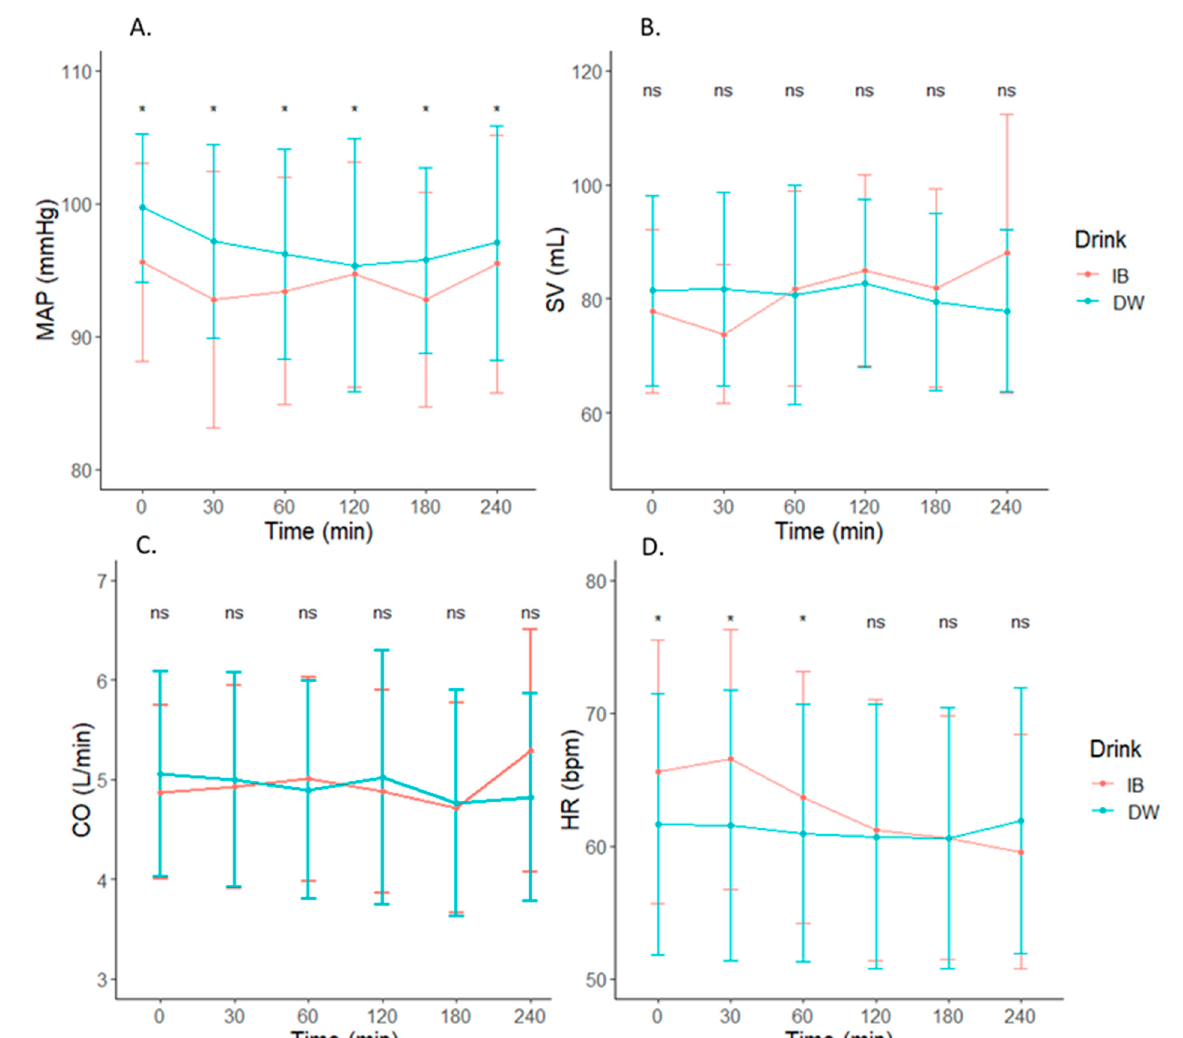
Figure 4. Changes in ( A ) mean arterial pressure (MAP), ( B ) stroke volume (SV), ( C ) cardiac output (CO), and ( D ) heart rate (HR) following consumption of isotonic beverage (IB) or distilled water (DW). * in ( A ) denotes a significant main effect of Drink ( p < 0.05). * in ( D ) denotes a significant Drink x Time interaction, p < 0.05. Non-significant interactions are denoted by ns in all figures. There was no Drink x Time interaction for lnRMSSD or lnLF ( p > 0.05, Figure 5A–D). lnHF was significantly greater 30-min post water ingestion compared to IB. There was no significant Drink ( p = 0.880), Time ( p = 0.465), or Drink x Time interaction effect ( p = 0.371) on the systolic time interval pre-ejection period (PEP) (Figure 5).